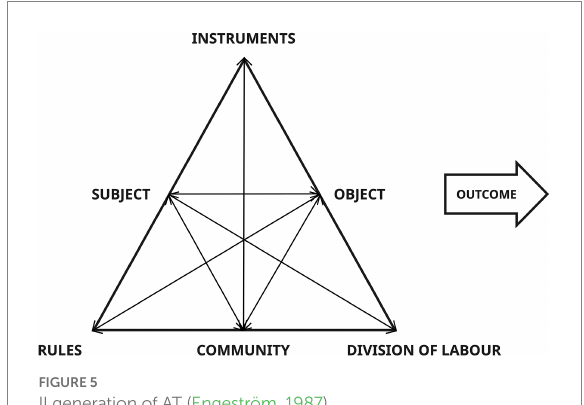
FIGURE 5 II generation of AT (Engeström,